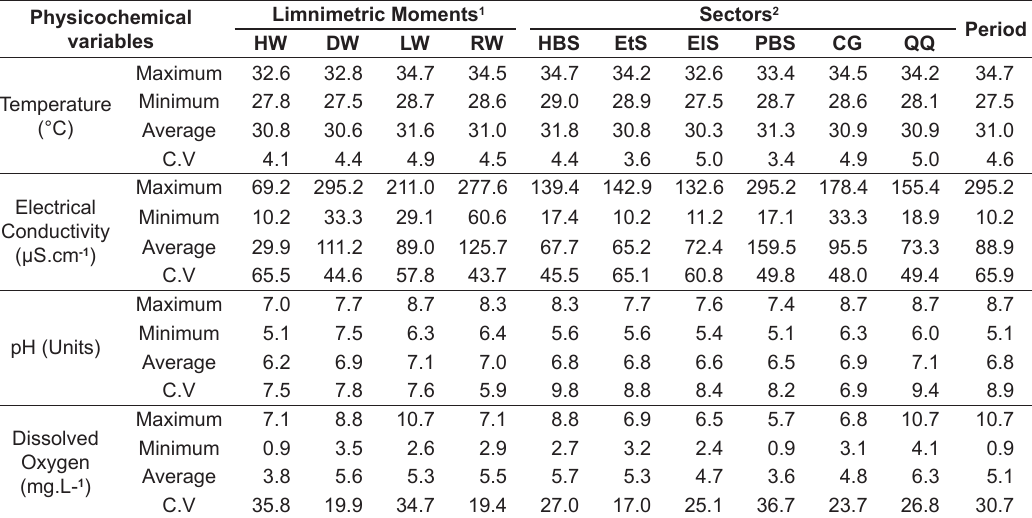
Table 3. Physicochemical variables in the Ayapel Swamp Complex (ASC) during different limnimetric moments and sampling